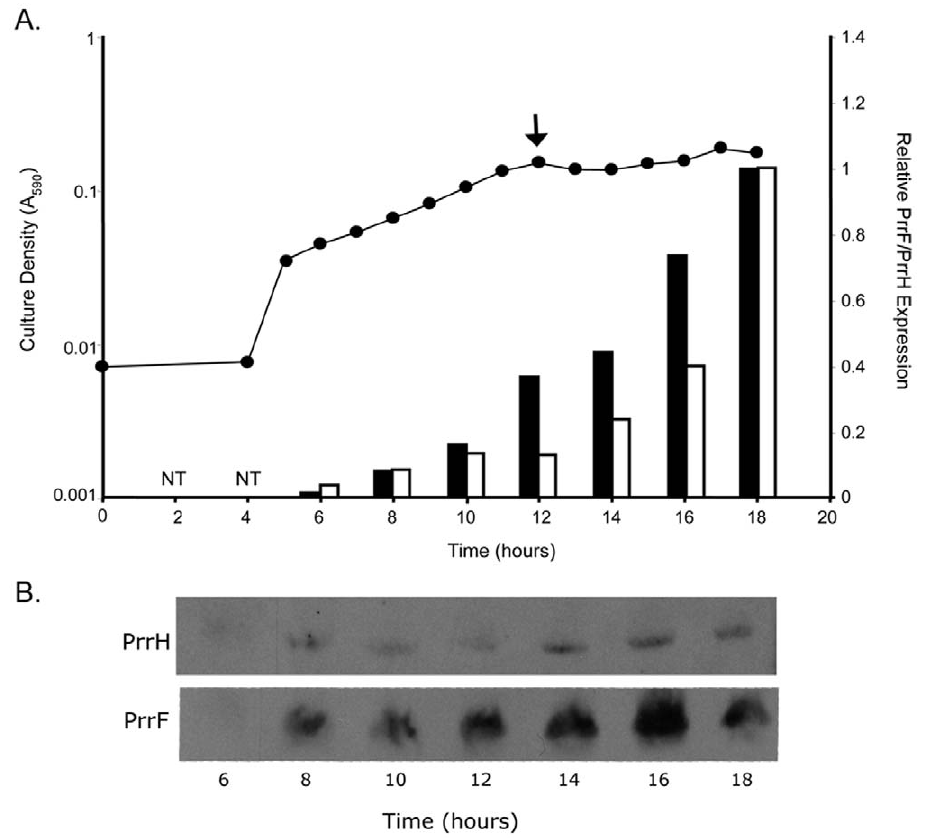
Figure 4. PrrF and PrrH are maximally expressed during stationary phase in iron-depleted medium. A. PA01 was grown in CM9 + 1% glycerol for 18 hours, taking culture density (A 590 ) measurements every hour. After the cells began growing logarithmically ( , 5 hours) samples were taken for RNA isolation every two hours. Arrow indicates the onset of pyoverdin production. qRT-PCR analysis as described in the Materials and Methods was used to quantify PrrF (black bars) and PrrH (white bars) expression. B. RNA samples were also analyzed by northern blot as described in the Materials and Methods to detect the presence of the PrrF and PrrH RNAs.